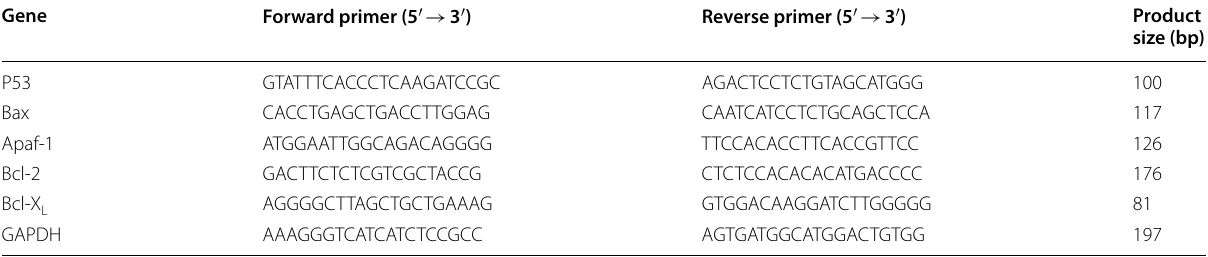
Table 1 Primer sequences and their product size used in qRT-PCR analyses of Dalton’s lymphoma ascites (DLA) bearing mice treated with aqueous extract of M. macrophylla (100 mg/kg